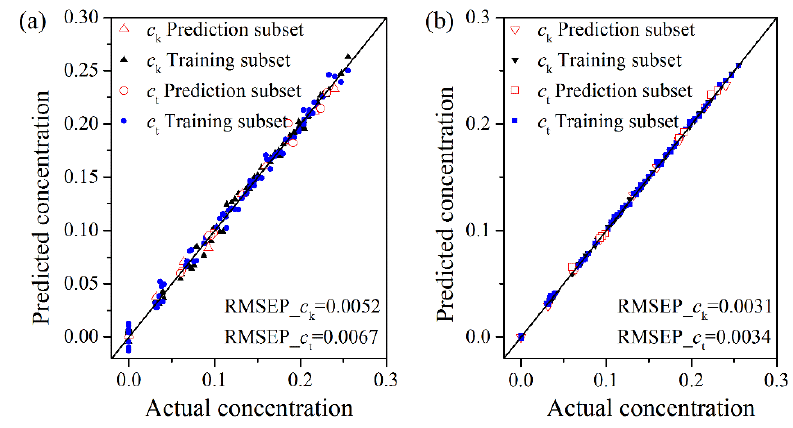
Figure 8. The predicted values vs. the actual values using ( a ) the optimal PLS model and ( b ) the optimal LS-SVM